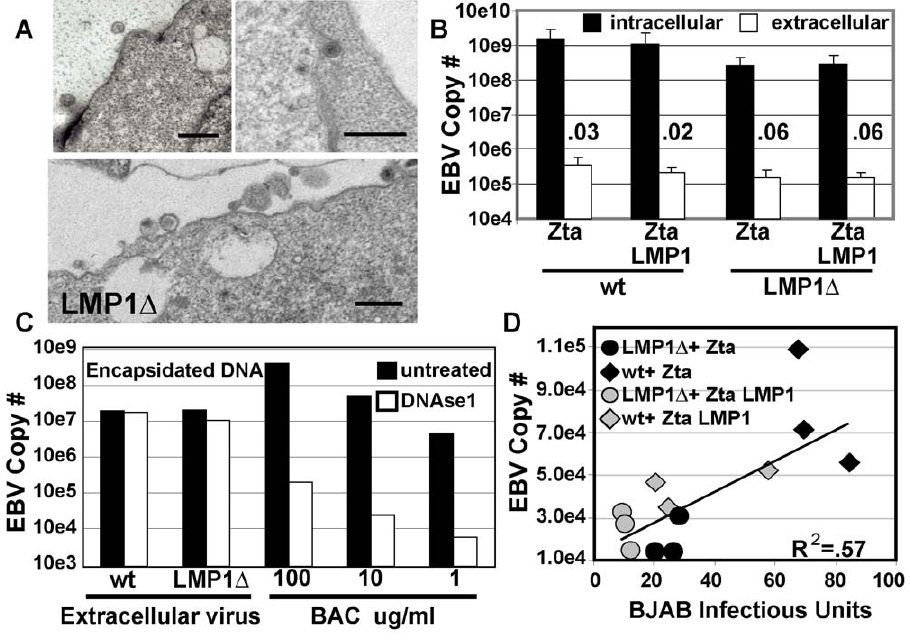
Figure 3. LMP1 D virus shows no defect in egress, encapsidation or infectivity. (A) 3 representative Transmission Electron Micrographs of HEK293 cells producing LMP1 D virus, black bars=500 nm. (B) LMP1 D virus shows no defect in egress from HEK293 cells. Quantization of intracellular and extracellular EBV DNA by qPCR for BALF5 (not normalized to gp350). Ratio between the two is presented (n . 5, standard deviation is shown). (C) Extracellular LMP1 D virus is encapsidated normally. Extracellular virions were digested with or without DNAse 1 and quantitated by BALF5 qPCR. BAC DNA produced in E. Coli served as a DNAse sensitive control (n=2). (D) LMP1 D virus is equally infectious as wt virus. BJAB was infected and colony formation after puromycin selection was determined at 4–6weeks post infection. BJAB infectious units are plotted as a function of EBV BALF5 copy number in the supernatants (n=3). The relationship between EBV copy number and BJAB infectious units is linear, R 2 =.57. Open symbols, LMP1 was transfected with Zta, closed symbols, Zta alone.